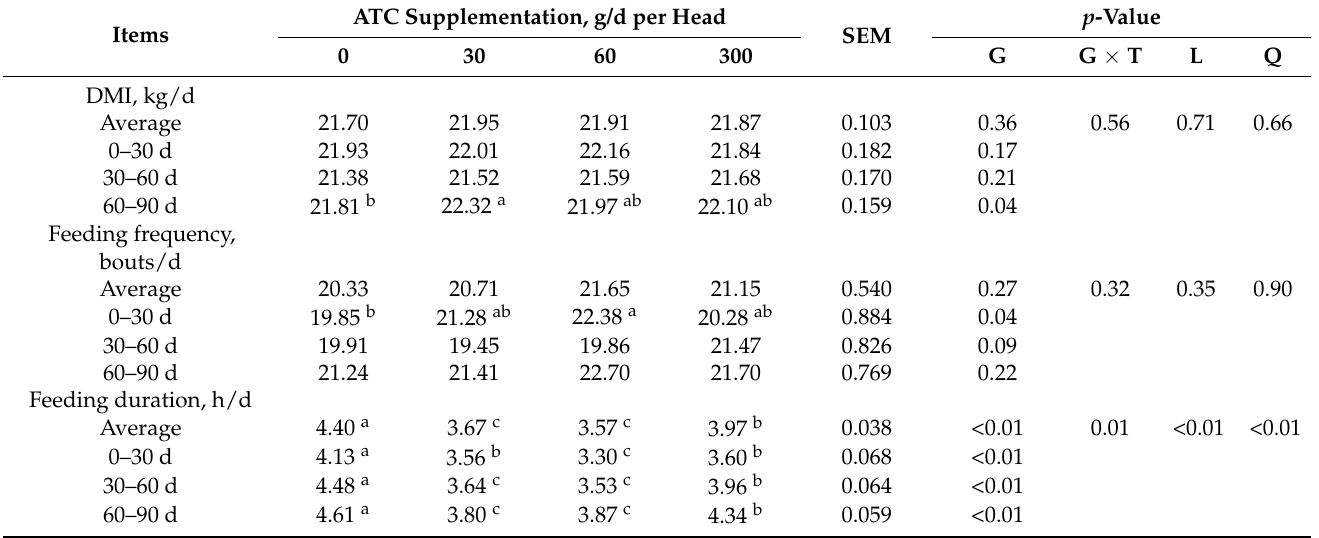
Table 1. Effect of different amounts of Acremonium terricola culture on feeding behavior in lactating dairy